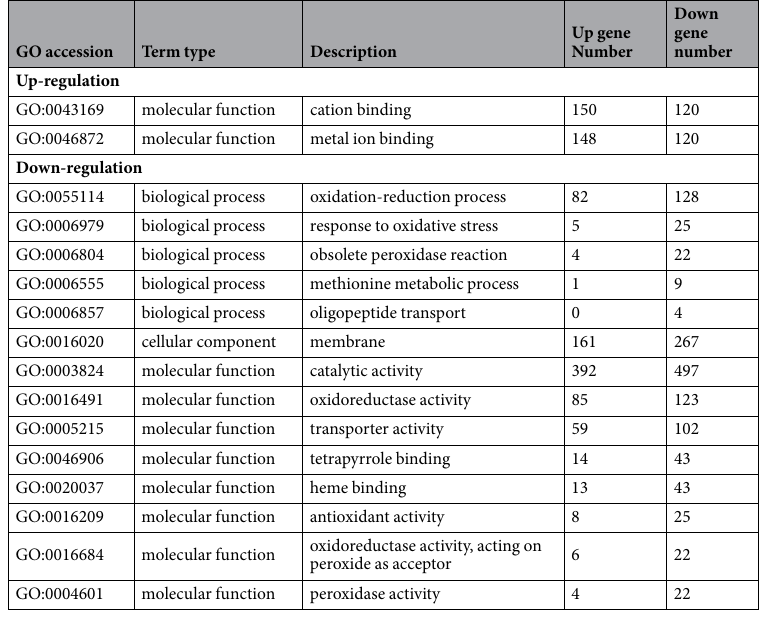
Table 1. Top several GO enrichments based on DEGs of DacR5htr vs DacR5hck.